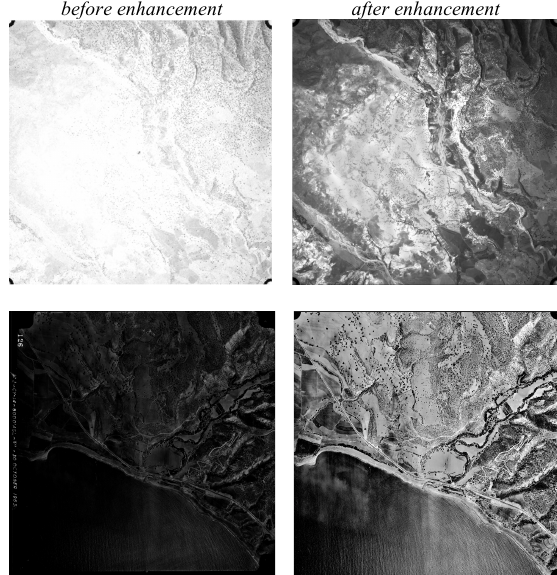
Figure 2. Exposure, contrast and brightness correction for the 1957 (upper images) and 1963 (lower images) Cyprus blocks.